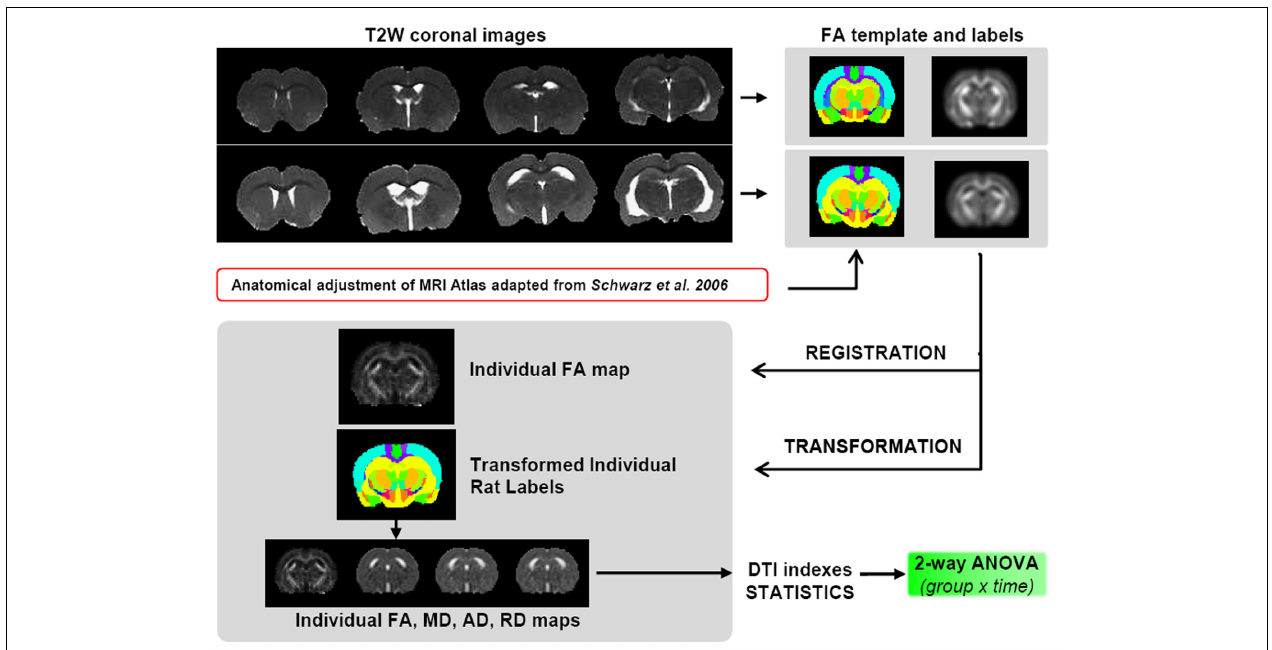
FIGURE 2 | Scheme of the DTI data processing. SHRs have enlarged ventricles compared to control animals, thus it is not viable to perform the registration process for a unified voxel based analysis. Therefore, two different FA templates were created, one for controls and one for SHRs, including a corresponding atlas of neuroanatomical structures. To avoid